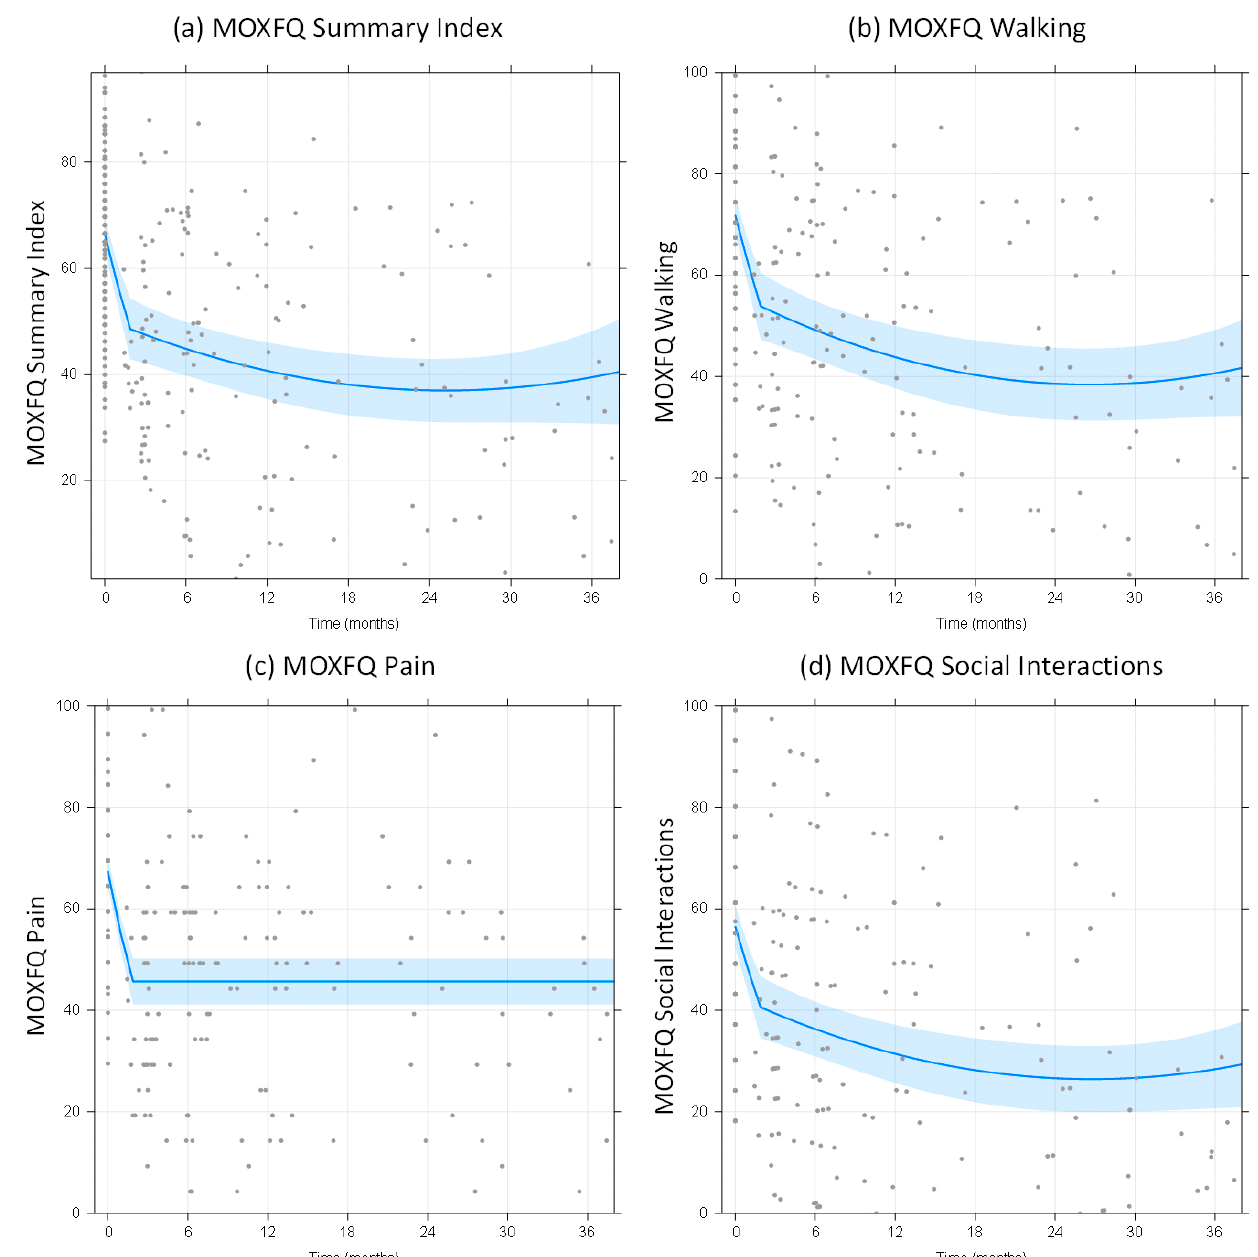
Figure 1. Mean MOXFQ for ( a ) summary index and sub-components of MOXFQ: ( b ) walking score ( c ) pain score ( d ) social interaction score over time, showing an initial rapid reduction compared to baseline scores with a sustained improvement over the follow-up period. In all 4 figures, the light shaded area represents the 95% CI band, and the grey dots represent all individual datapoints.